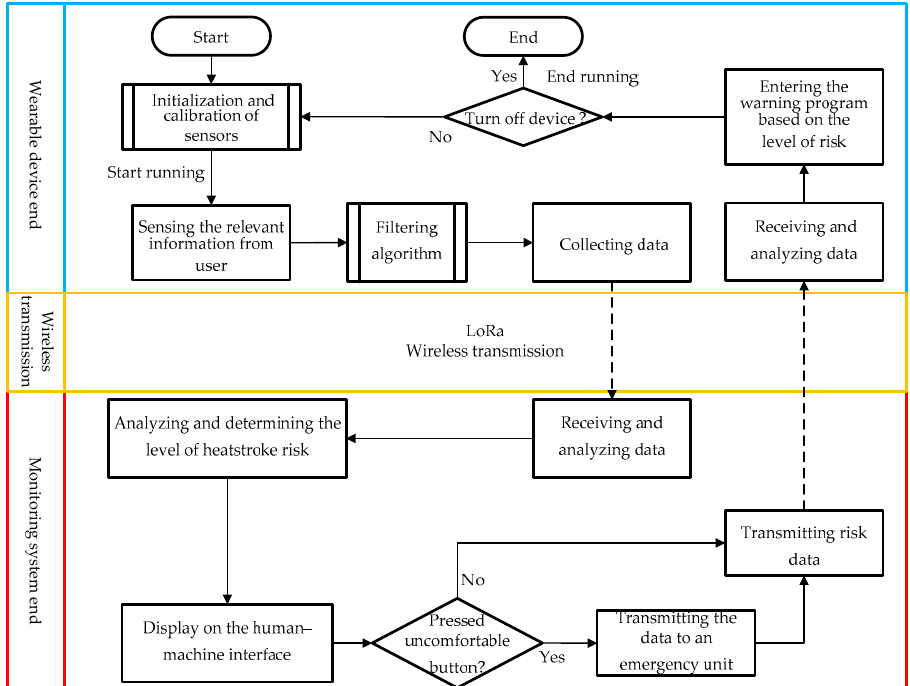
Figure 3. Workflow of the WHDD.